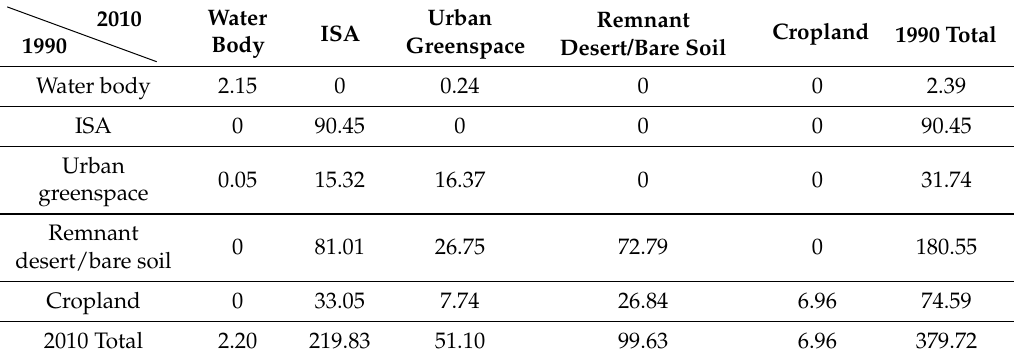
Abbreviation: ISA—impervious surface